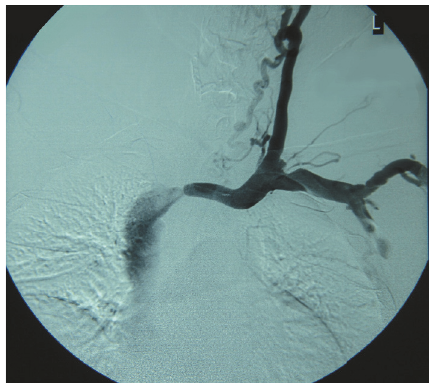
Figure 2: Vascular access angiography: stenosis of the left brachio- cephalic vein close to the superior vena cava.